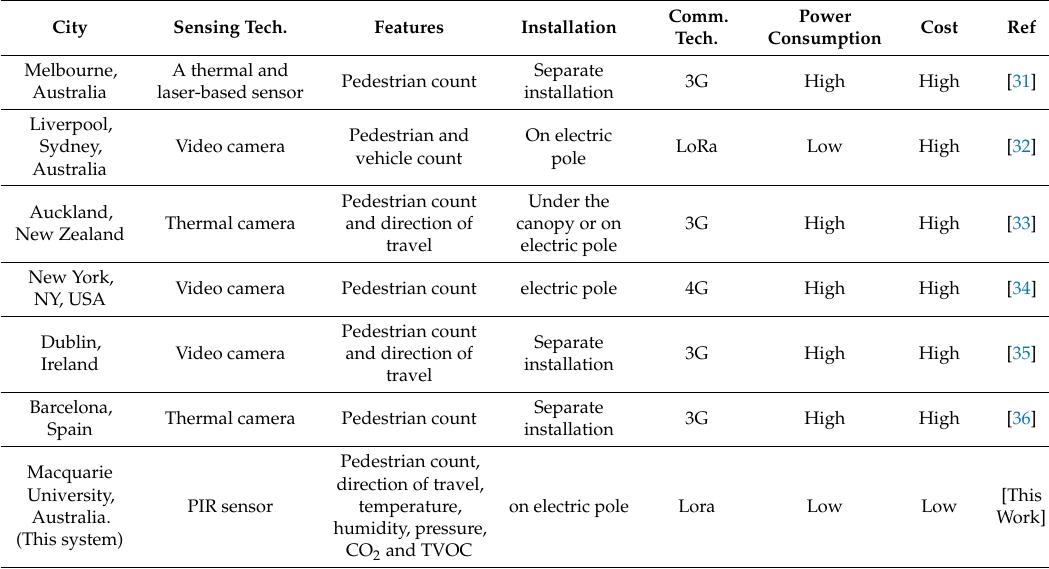
Table 1. Comparison of the existing pedestrian counting system in smart cities